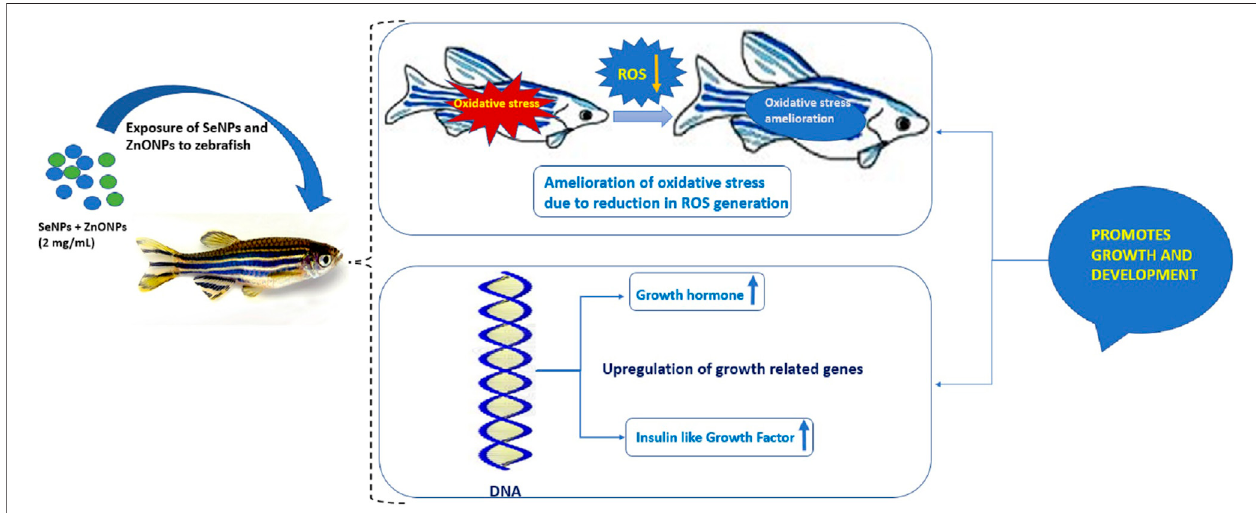
FIGURE6| MechanisticdiagramdelineatingtheeffectofcombineduseofSeNPandZnONPsonzebra fi shexhibitinghighergrowthperformanceduetoreduction of oxidative stress (OS) and ROS and upregulation of growth-regulated genes.